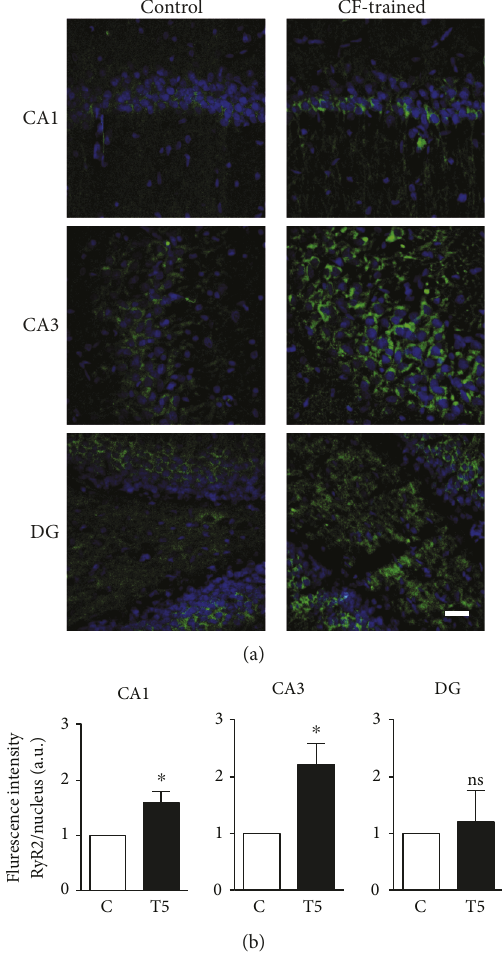
nsDGCA3CA1 1 0 Figure 2: Contextual fear training promotes RyR2 upregulation in situ. (a) Representative confocal images of RyR2 immuno fl uorescence (green) and nuclear stain (blue) obtained from the CA1, CA3, and DG hippocampal regions. Samples were obtained 5h after training animals (T5) in the contextual fear protocol or from controls similarly exposed to the context in the absence of the electric shock. Scale bar: 20 μ m. (b) Normalized RyR2 immuno fl uorescence values. To calculate these values, RyR2 immuno fl uorescence in the entire image was divided in each case by the corresponding nuclear stain, and the control ratios were set as 1. Values represent mean ± SE; N = 3 for the T5 and the control groups. Statistical analysis was performed with paired one-tailed Student ’ s t -test. ∗ p < 0 05 ; ns: not signi fi